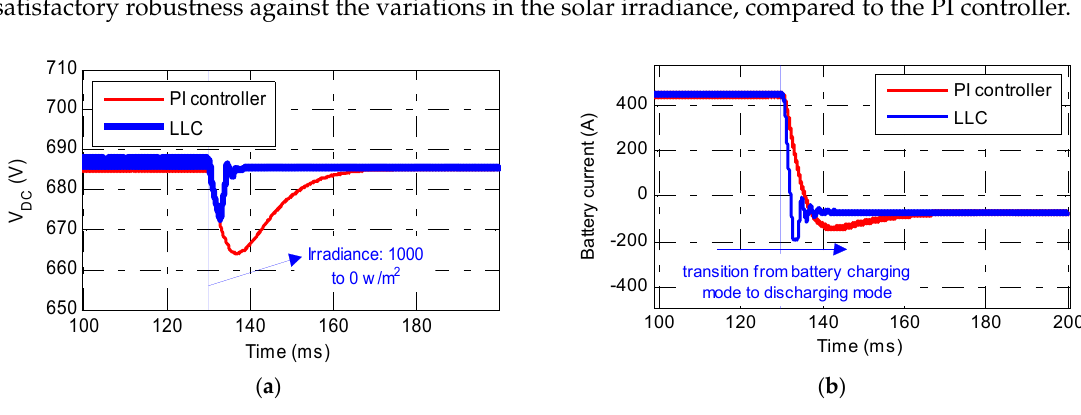
Figure 10. ( a ) Response to variations in irradiance; and ( b ) profile of battery current during irradiance